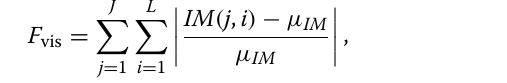
where IM ∈ R J × L is an image patch, μ IM is the aver- corresponding position, J and L represent the rows and the changing characteristics on the image value in space. image patch. It can be defined as